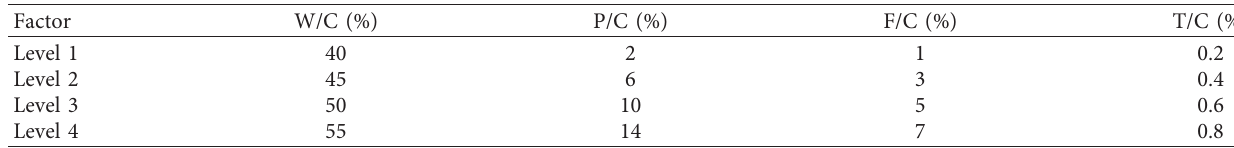
Table 7: Experiment factor level table.